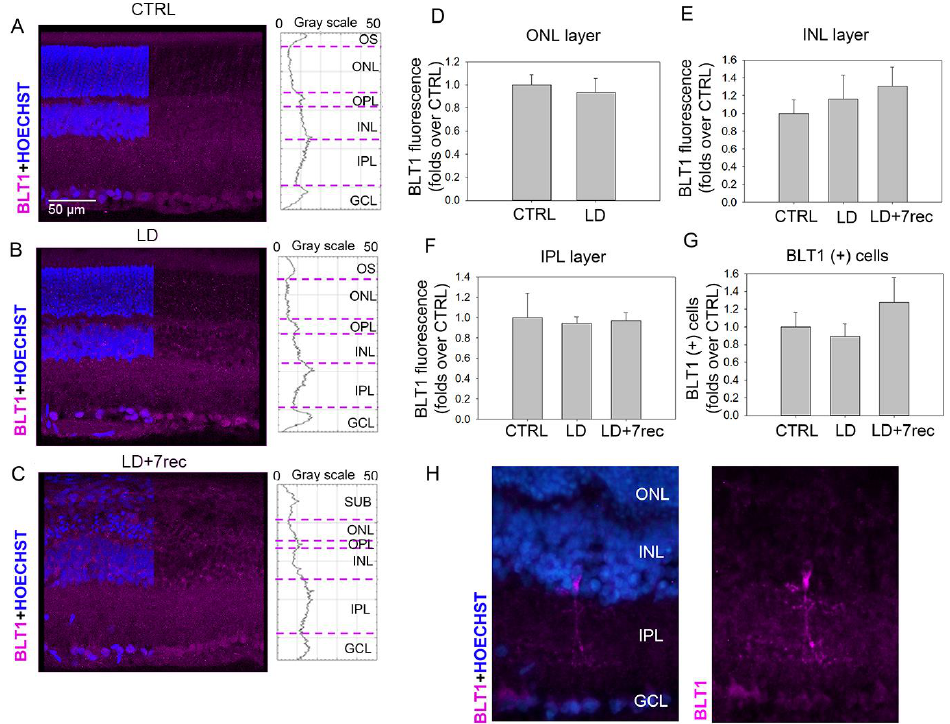
Figure 5. BLT1 analysis. ( A – C ) Confocal images and plot profile of fluorescence intensity of retinal cryosections from CTRL, LD and LD + 7rec groups, respectively, immunolabelled for BLT1 (pink). Nuclei were stained with Bisbenzimide (blue). The images refer to the central dorsal area of the retina. Scale bar: 50 µm. BLT1 fluorescence intensity in ( D ) the ONL; ( E ) the INL; ( F ) in the IPL. ( G ) Quantitative analysis of BLT1 (+) cells from the superior to the inferior edge of retinal cryosections. Data are shown as mean ± SE ( n = 4). ( H ) High magnification of random BLT1 (+) cells (pink). CTRL (Control); LD (Light damage); LD + 7rec (Light damage + 7 days of recovery); OS (outer segments); ONL (Outer nuclear layer); OPL (outer plexiform layer); INL (Inner nuclear layer); IPL (inner plexiform layer); GCL (Ganglion cell layer).